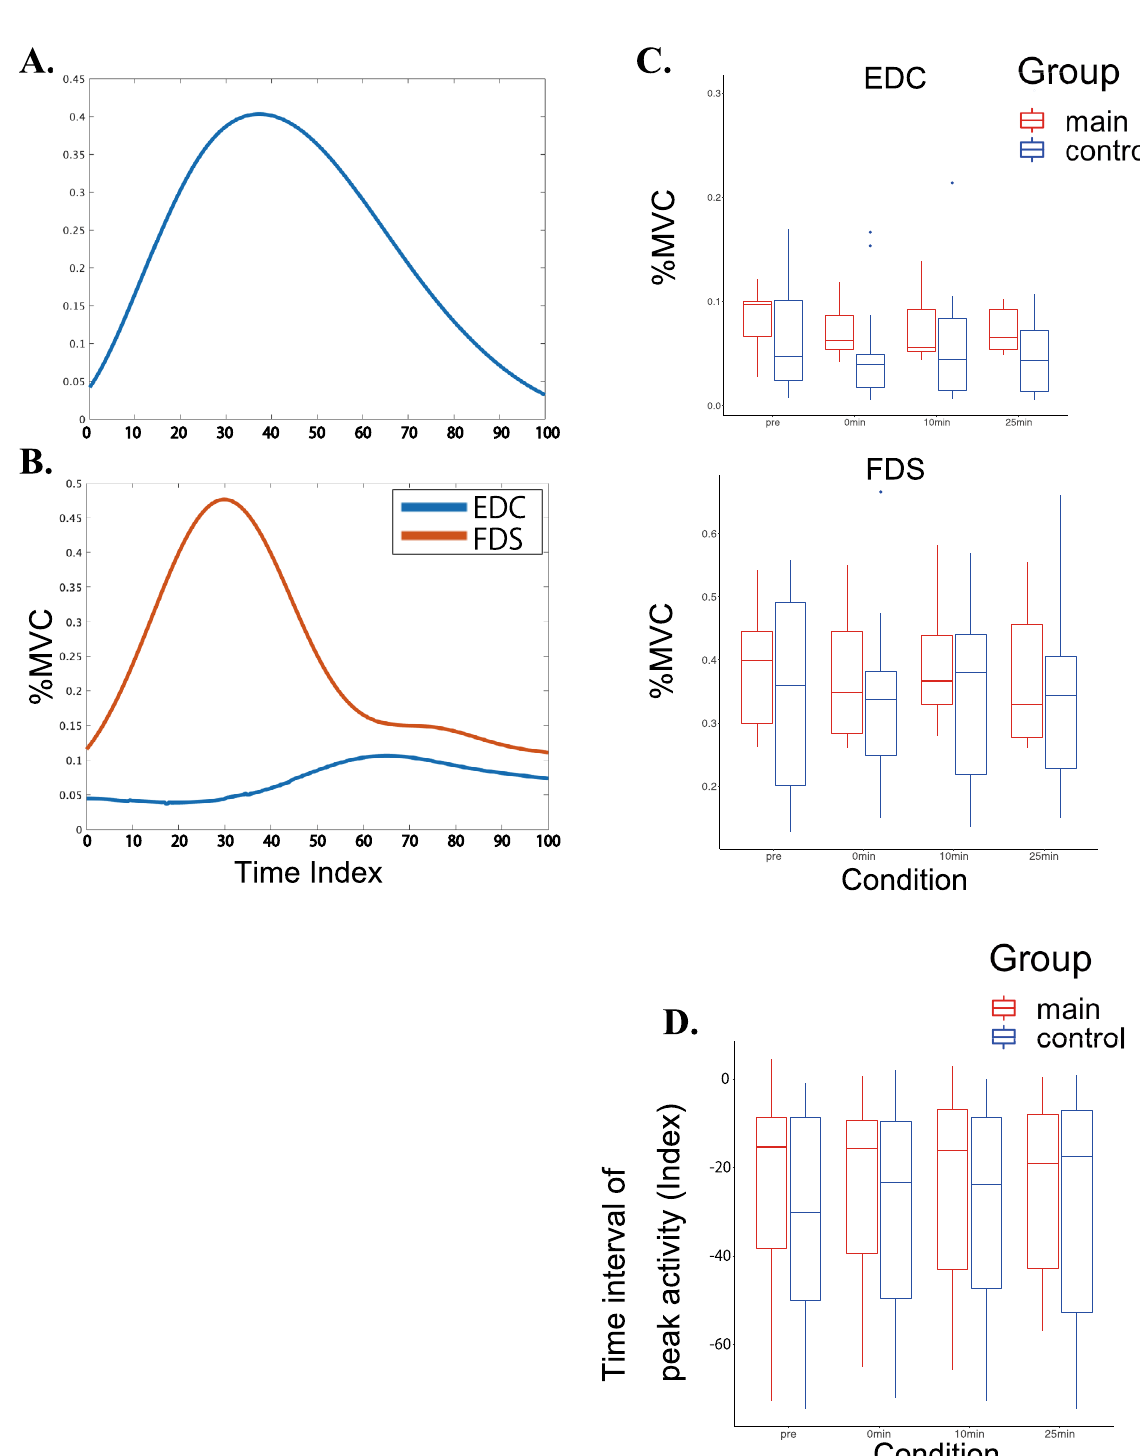
Figure 5. ( A ) and ( B ) Representative examples of the time-varying trajectory of the finger pressing force ( A ) and its corresponding muscular activities of the finger extensor and flexor muscles (i.e. EDC and FDS) ( B ) of one representative pianist in the main group The x-axis indicates the normalized time so that the period from the initiation to the termination of the force production can be 100 timepoints. ( C ) Box plots of group means o the maximum values of the muscular activities at the EDC and FDS before and after the conditioning session in the main (red) and control (blue) groups. ( D ) Box plots of group means of the interval of the timing of the peak activities between EDC and FDS in the main and control groups. The negative value indicates when the peak FDS activity preceded the peak EDC activity. *p < 0.05, **p <